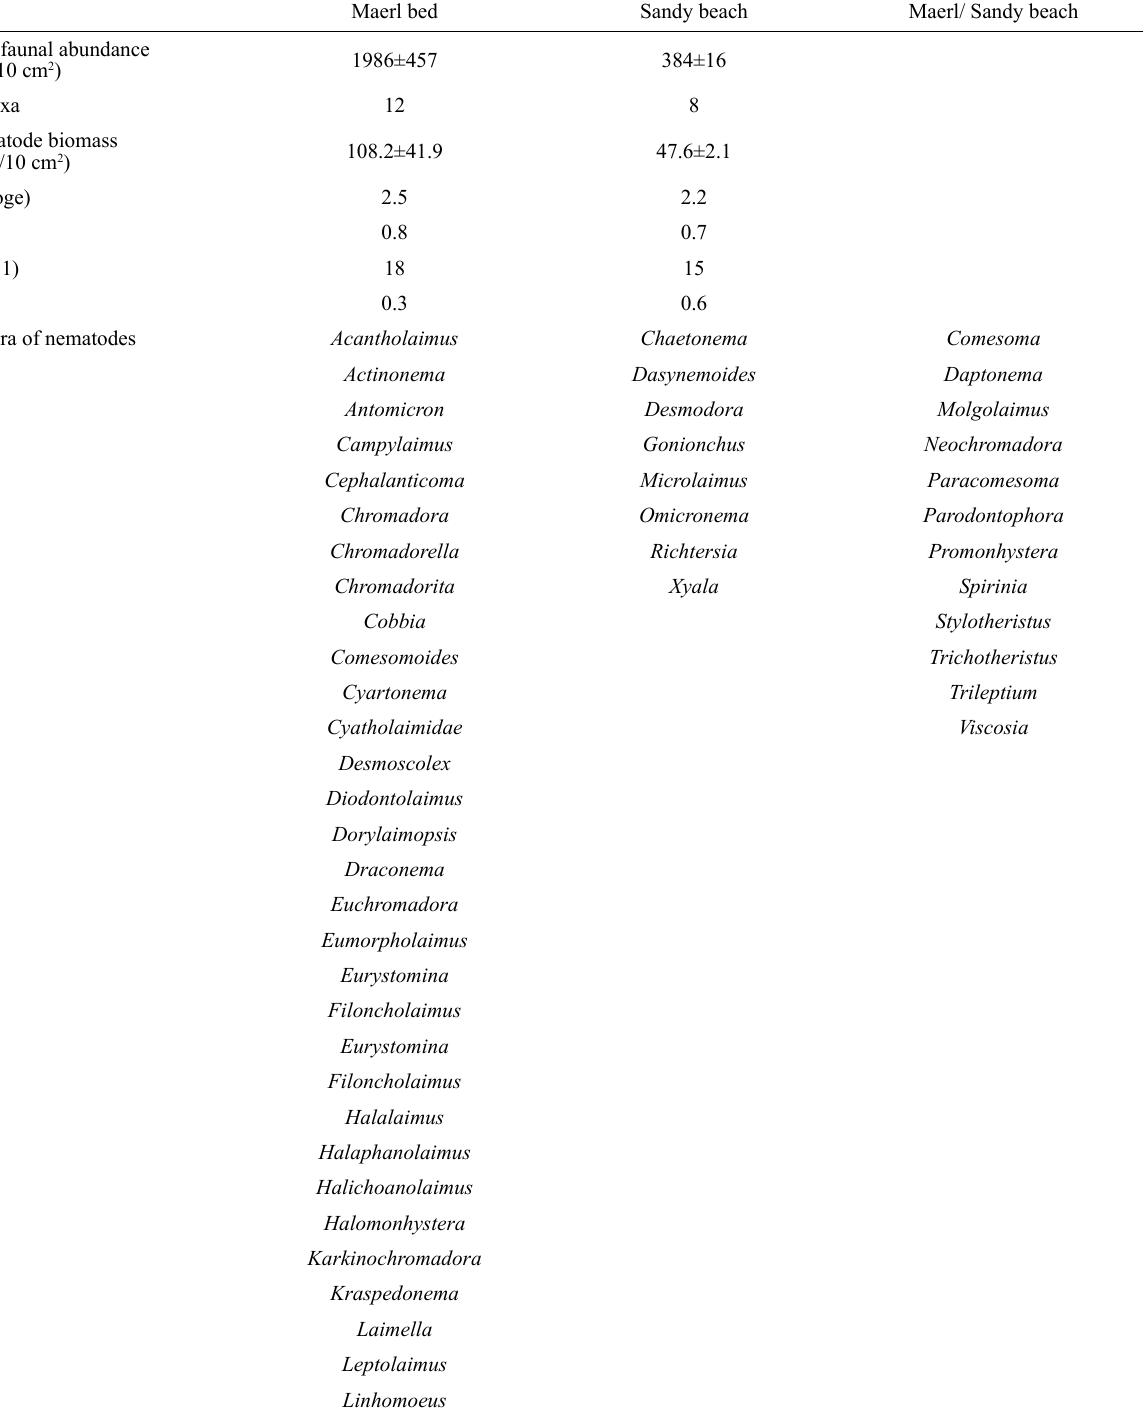
Table S6. – Meiofaunal abundance, number of higher taxa, nematode biomass, diversity (Shannon index (H’), equitability evenness (J’), expected genus number (EG(51)) and trophic diversity index (ITD)). List of exclusive and shared genera of nematodes between the maerl bed and the sandy